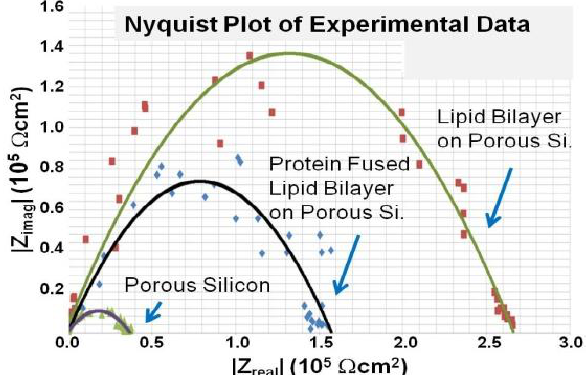
Figure 19. Nyquist plot with frequency range 0.1–100 kHz of the complete system. Reprinted with permission from Nano Science and Technology Institute